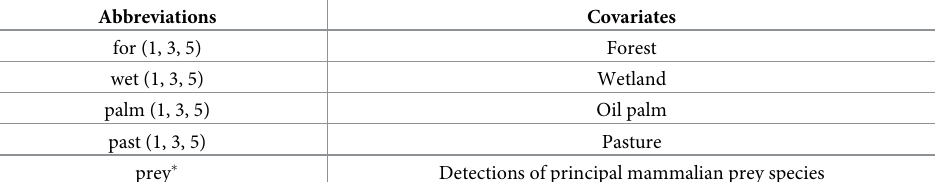
Table 2. Definitions of covariates (size of radii buffers in km). Summary of covariates used to evaluate jaguar habi- tat use in the middle Magdalena River valley,